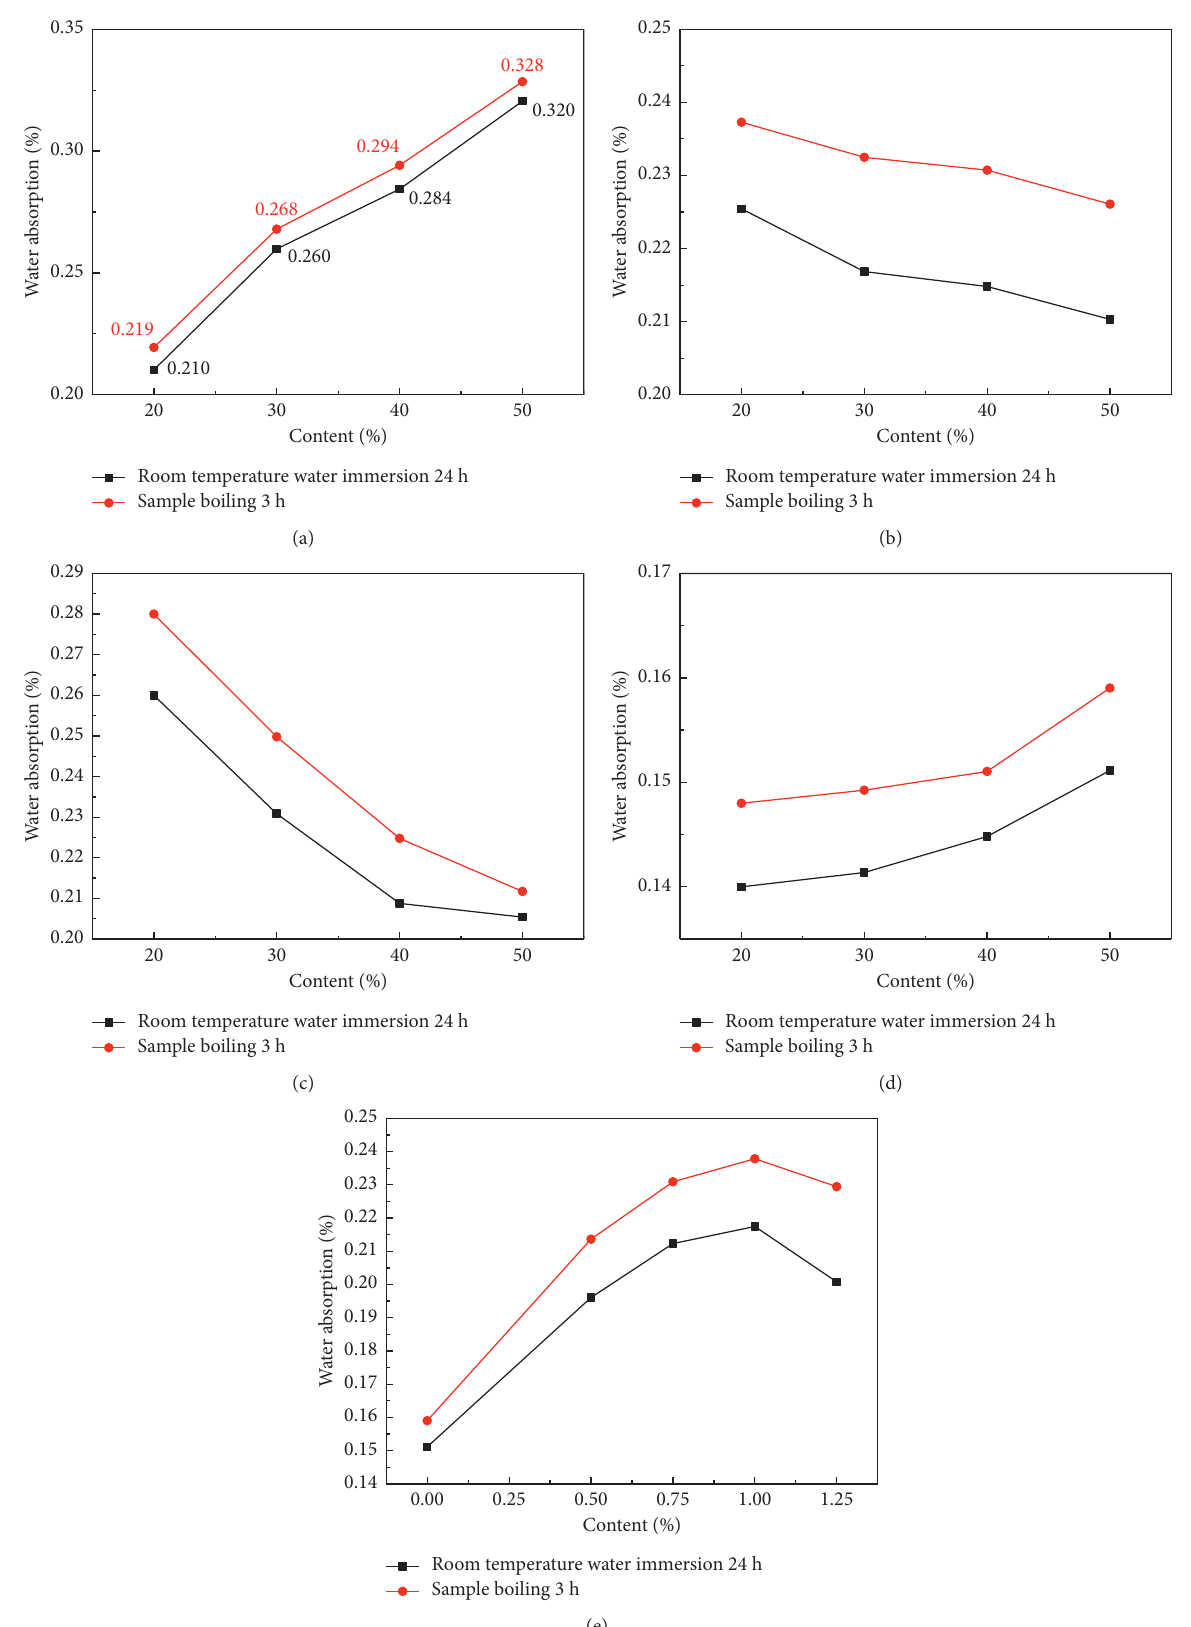
Figure 4: The influence of lime, fly ash (lime 30%), cement (lime 30%), fly ash (lime 10%, cement 5%), and polyvinyl alcohol (lime 10%, cement 5%, and fly ash 40%) dosage on water